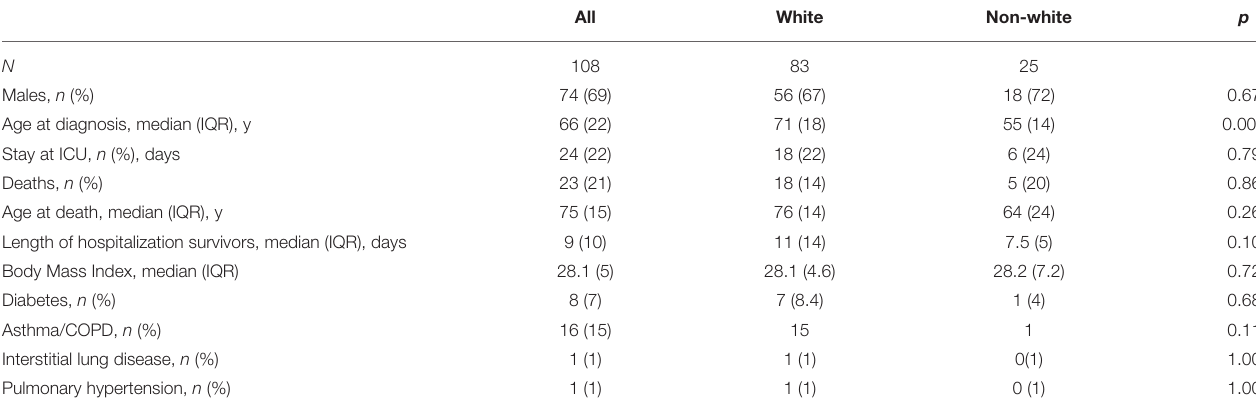
TABLE 1 | Characteristics of Dutch patients hospitalized with COVID-19. All White Non-white